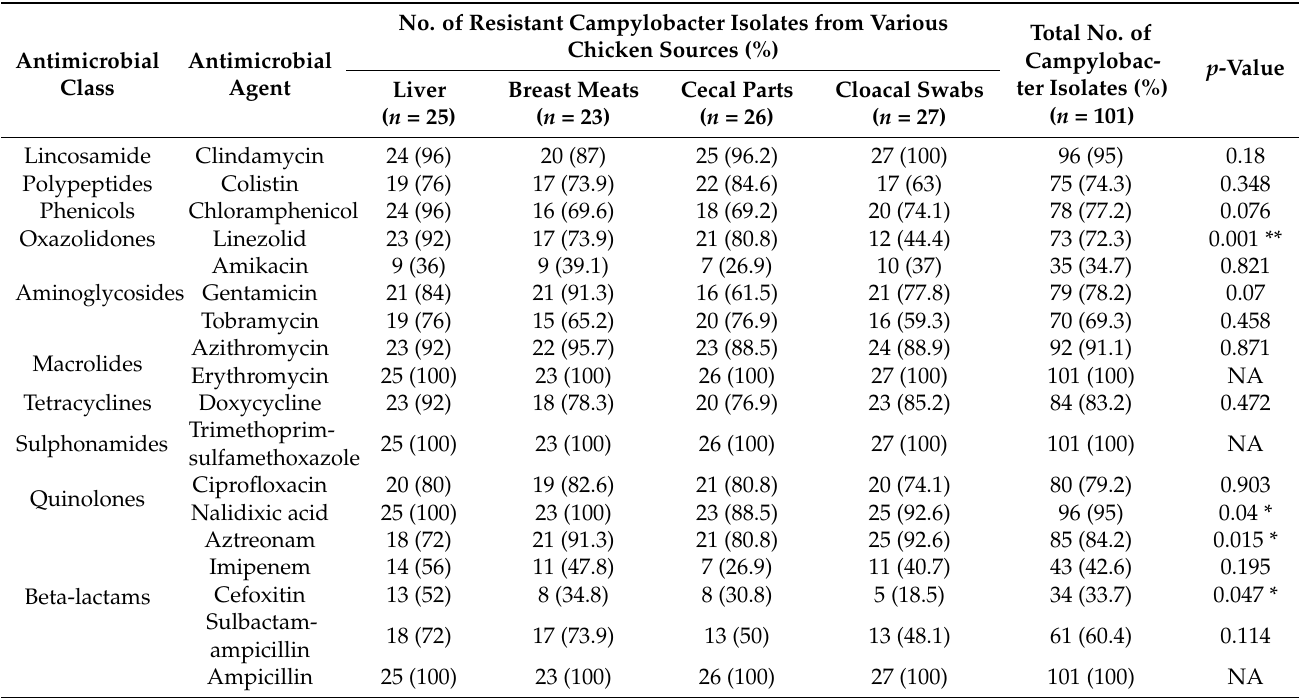
Table 5. Antimicrobial resistance patterns of the Campylobacter species from various chicken sources. No. of Resistant Campylobacter Isolates from Antimicrobial